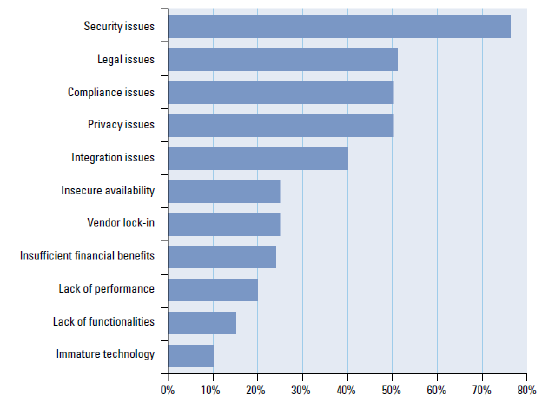
Figure 2. Concerns of Cloud